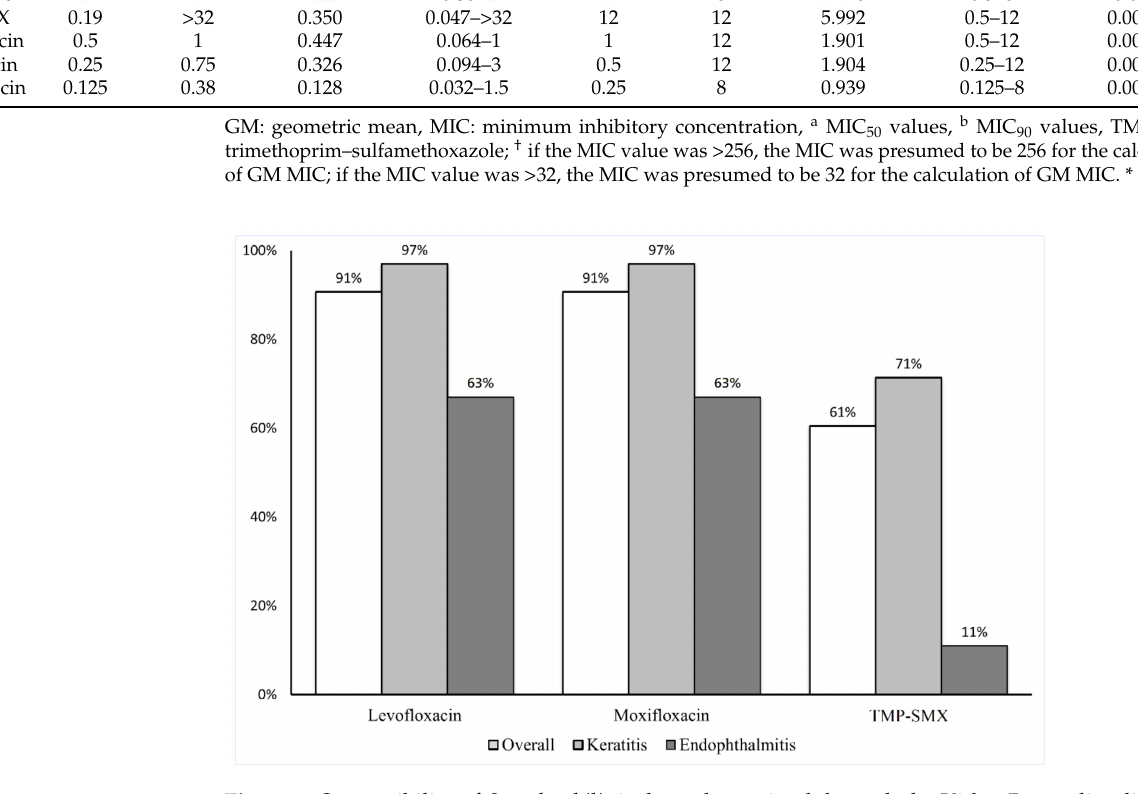
Figure 1. Susceptibility of S. maltophilia isolates determined through the Kirby–Bauer disc diffusion method. Of the 43 isolates, 39 (91%) were susceptible to levofloxacin and moxifloxacin, and 26 (61%) were susceptible to